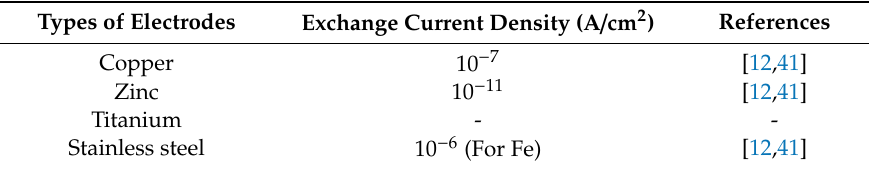
Table 5. Exchange current density of di ff erent types of